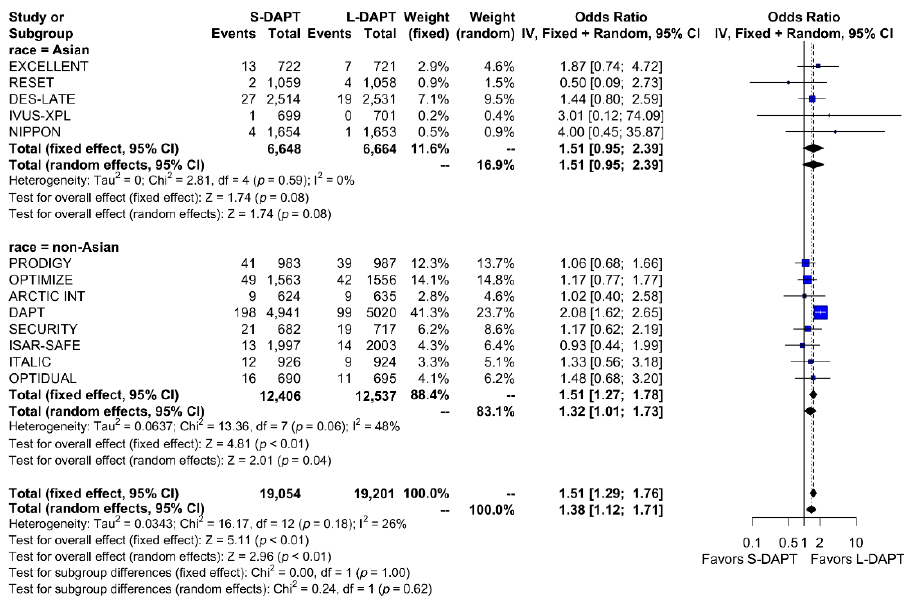
Figure 5. Myocardial infarction in randomized clinical trials. S-DAPT, short duration dual antiplatelet therapy; L-DAPT, long duration dual antiplatelet therapy; CI, confidence interval.